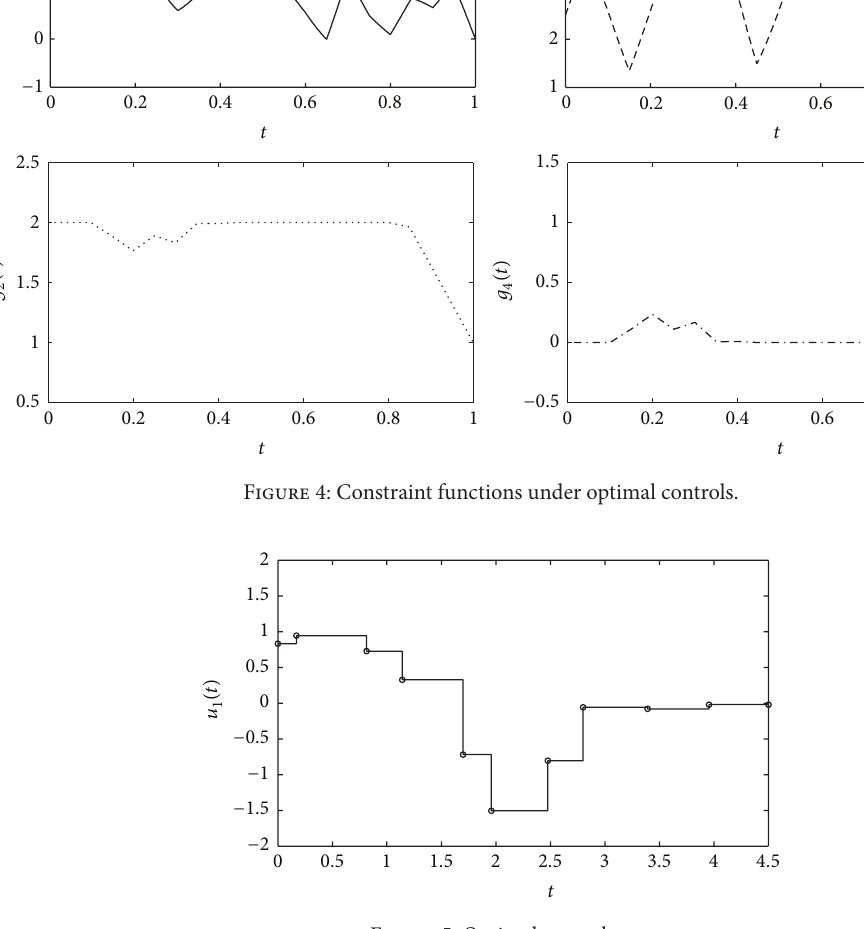
Figure 5: Optimal